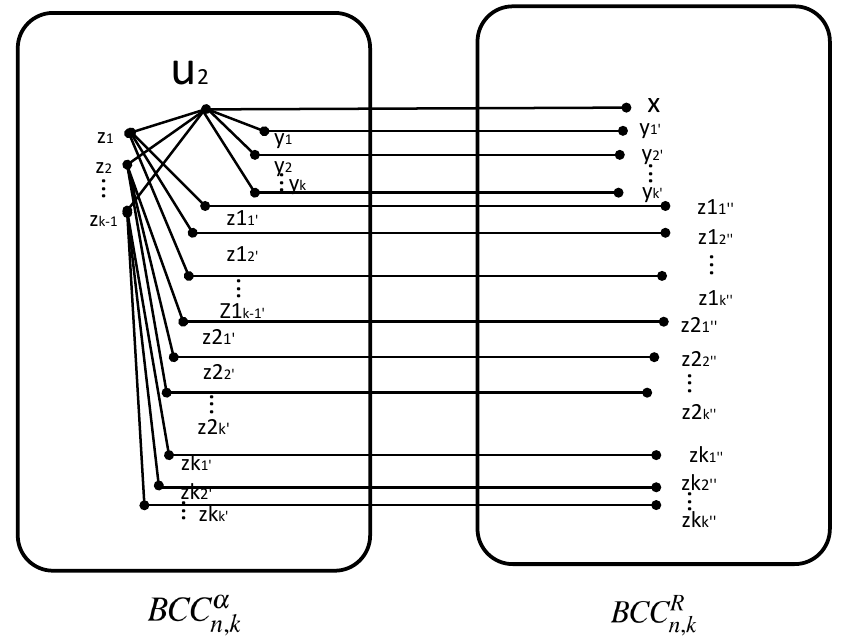
Figure 4. ( k − 1 )( n − 1 ) + n paths from u 2 to BCC R